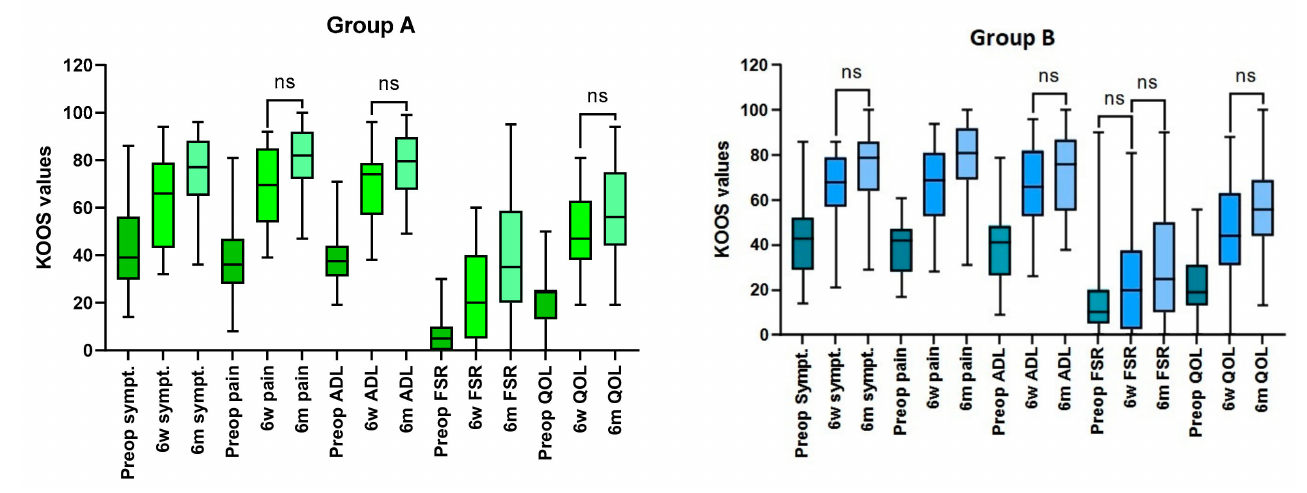
Figure 1. Group A—IFP resected, Group B—IFP preserved. KOOS scores in both groups (preoper- ative, 6 weeks and 6 months) of patients obtained at all check-ups. In comparison to preoperative values, all scores significantly improved at 6 months; when scores from consecutive examinations were compared as statistically significant (Friedman and post hoc Dunn tests) improvement was